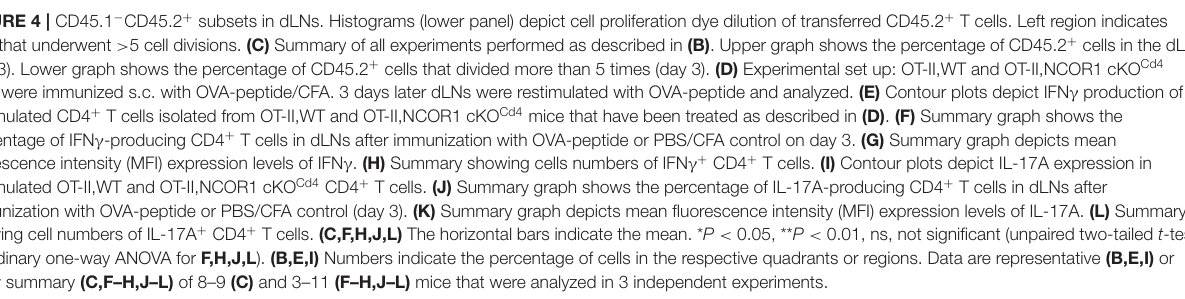
FIGURE 4 | CD45.1 − CD45.2 + subsets in dLNs. Histograms (lower panel) depict cell proliferation dye dilution of transferred CD45.2 + T cells. Left region indicates cells that underwent > 5 cell divisions. (C) Summary of all experiments performed as described in (B) . Upper graph shows the percentage of CD45.2 + cells in the dLN (day 3). Lower graph shows the percentage of CD45.2 + cells that divided more than 5 times (day 3). (D) Experimental set up: OT-II,WT and OT-II,NCOR1 cKO Cd4 mice were immunized s.c. with OVA-peptide/CFA. 3 days later dLNs were restimulated with OVA-peptide and analyzed. (E) Contour plots depict IFN γ production of restimulated CD4 + T cells isolated from OT-II,WT and OT-II,NCOR1 cKO Cd4 mice that have been treated as described in (D) . (F) Summary graph shows the percentage of IFN γ -producing CD4 + T cells in dLNs after immunization with OVA-peptide or PBS/CFA control on day 3. (G) Summary graph depicts